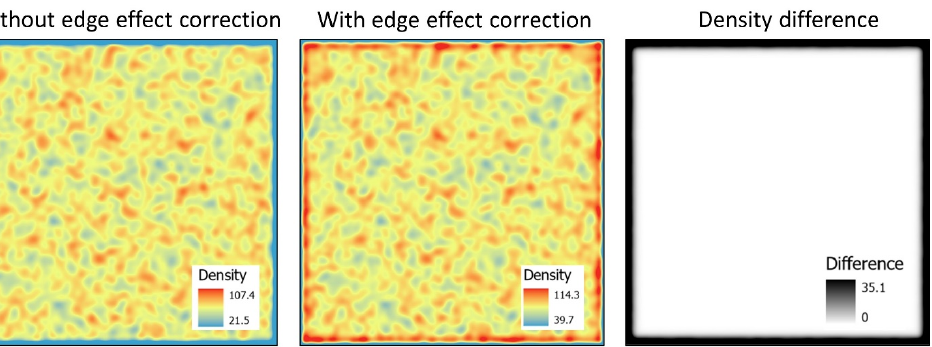
Figure 8. Density rasters estimated using ‘rule-of-thumb’ fixed bandwidth with or without edge effect correction, and their differences on a synthetic dataset ( n = 1,000,000 points; density raster cell size = 0.05). Table 5. Execution time (in seconds) for density estimation with edge effect correction on a synthetic